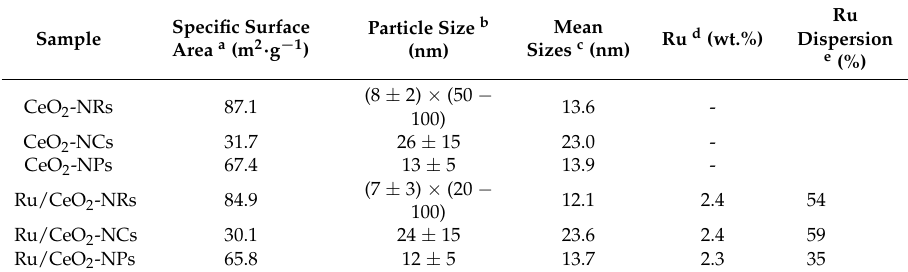
Table 1. Physical properties of various samples.